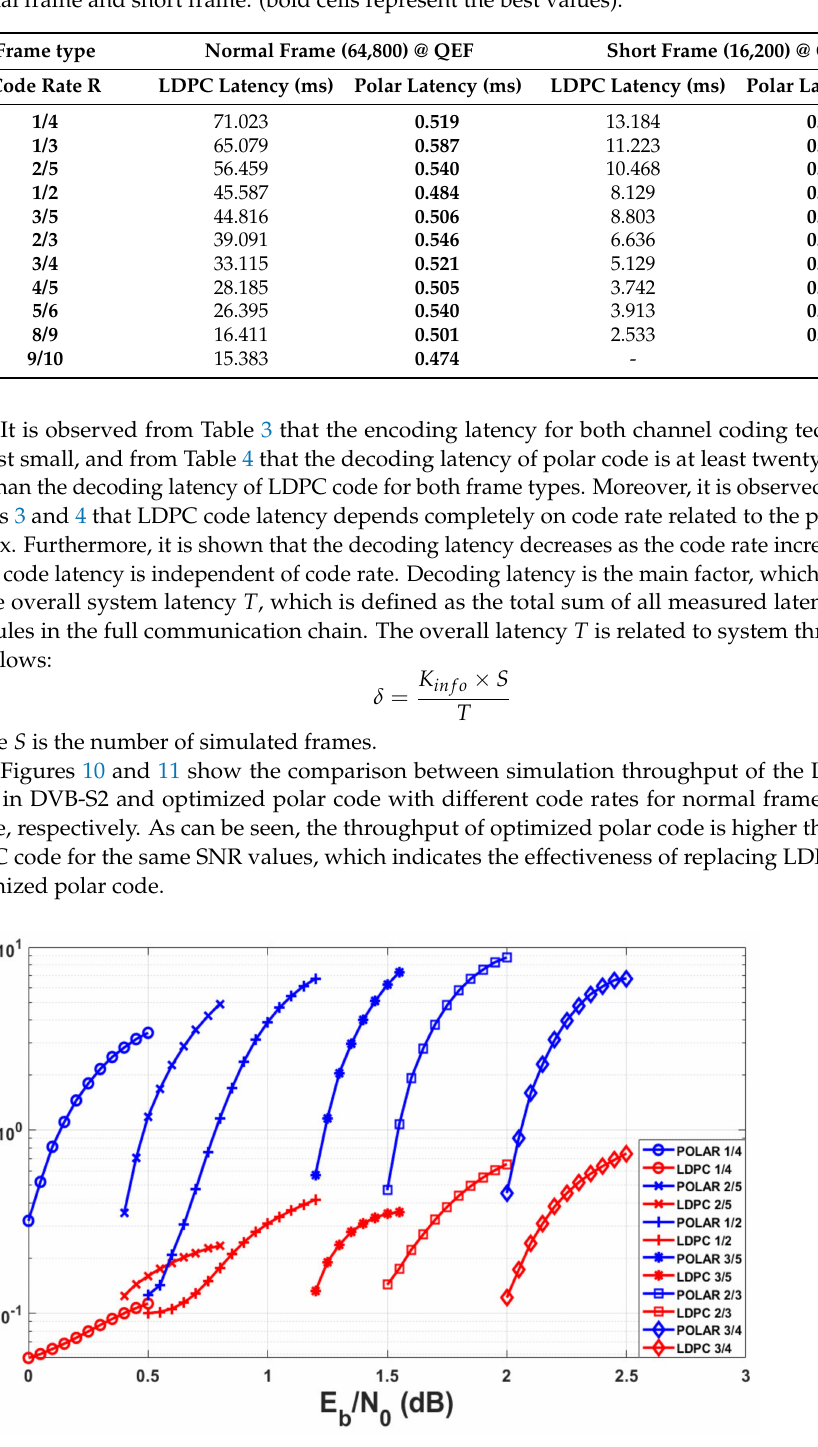
Figure 10. Throughput versus E b / N 0 for LDPC and optimized polar codes using normal frame with N = 64,800 and different code rates R in